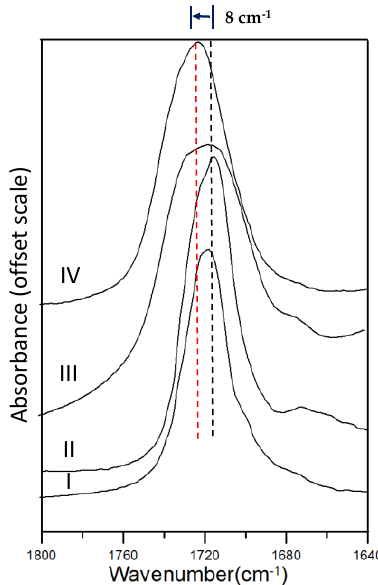
Figure 6. FTIR spectra of phenoxy/PBT (5/5) in the carbonyl group absorption region for blends annealing at 260 °C for 3 h. Spectrum ( I ) is the as-blended, ( II ) is the extracted solution, ( III ) is the heat-annealed blend, and ( IV ) is the leached solid.